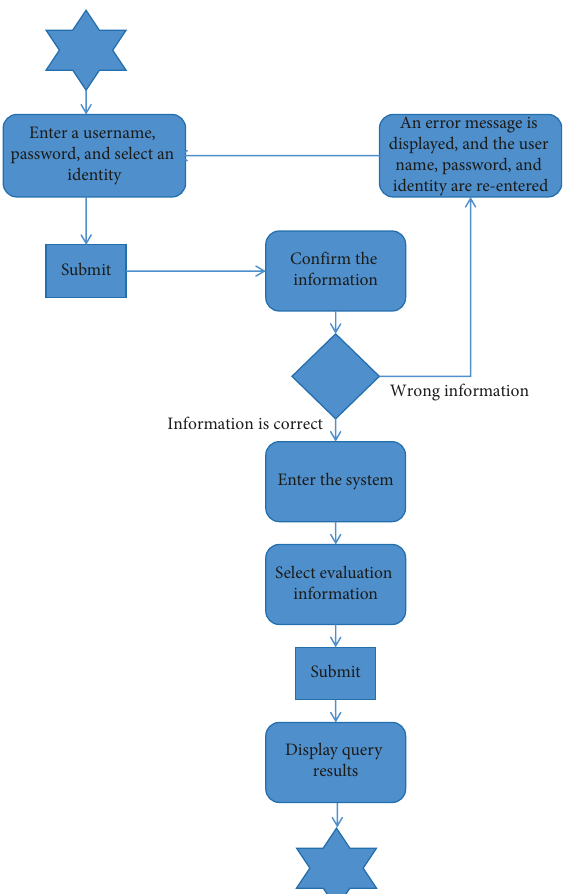
Figure 6: Activity diagram of user query and evaluation